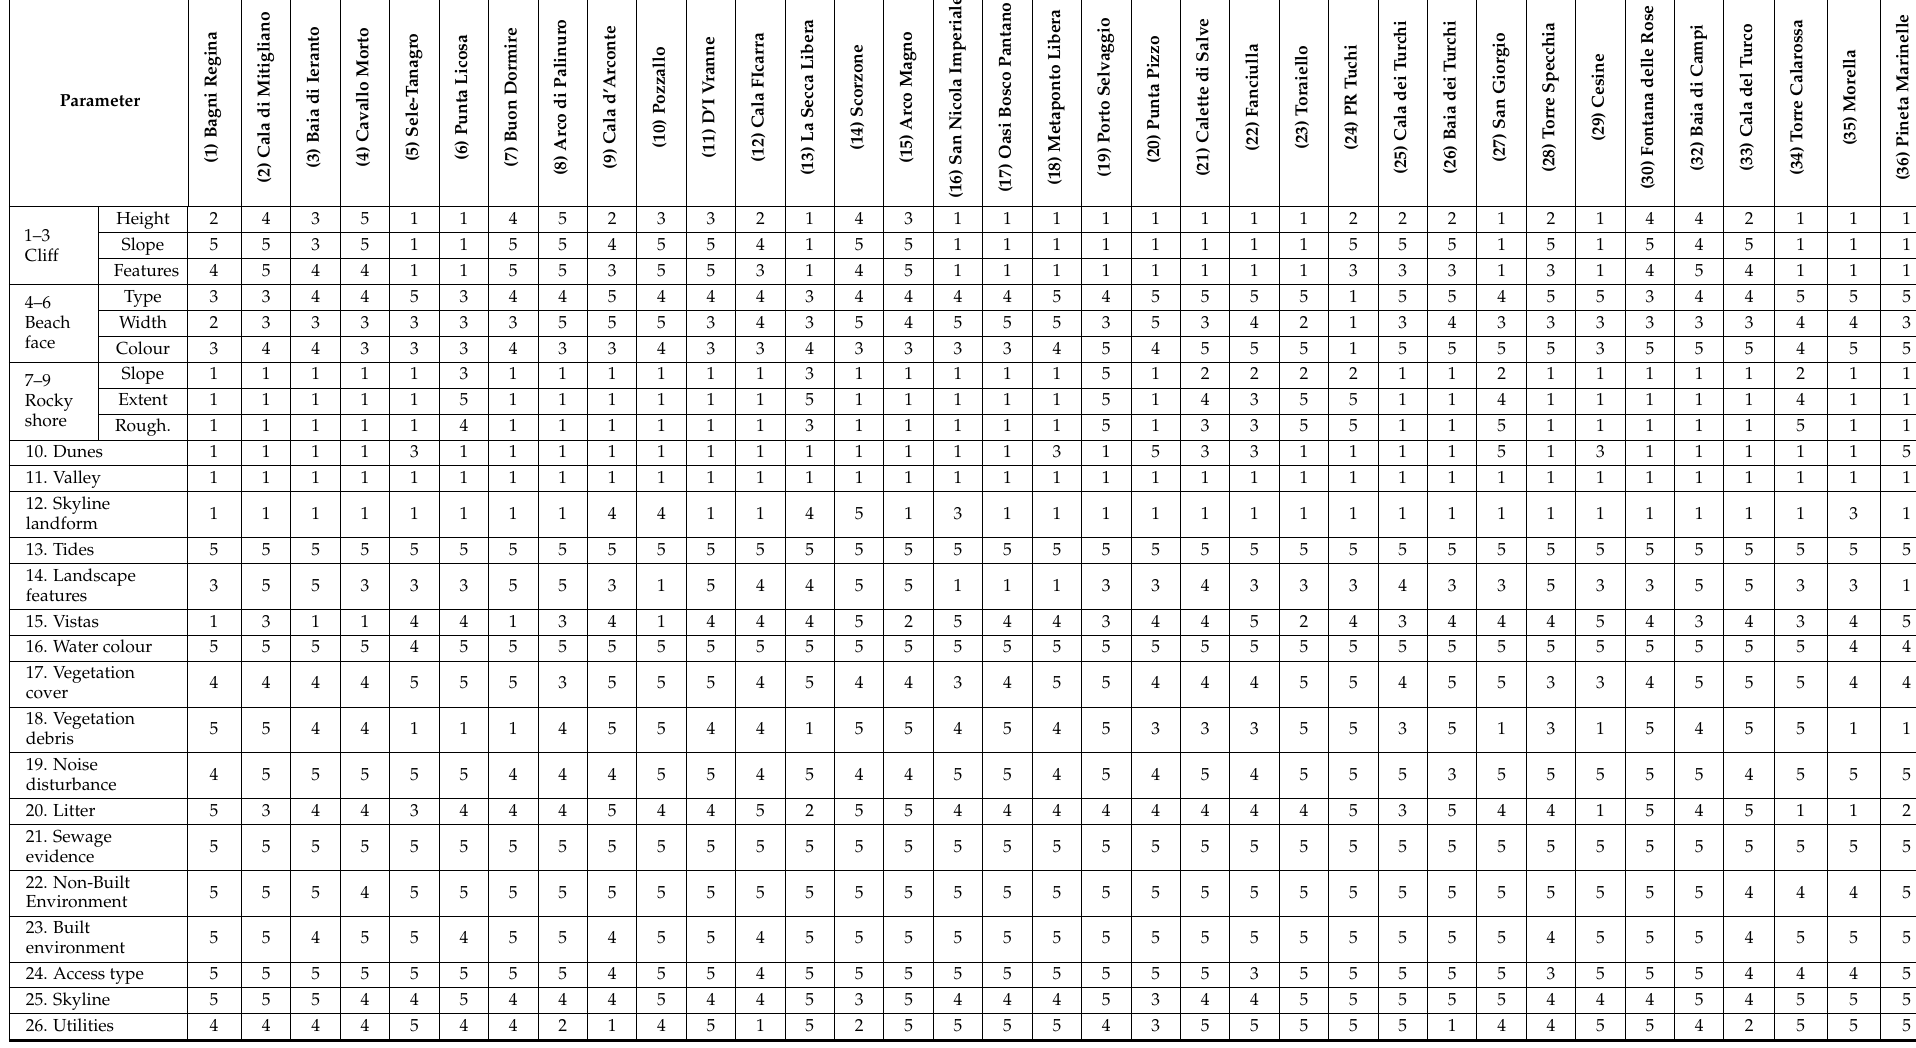
Table A2. Site scores obtained from CSES parameters: physical (1–18) and human aspects (19–26).